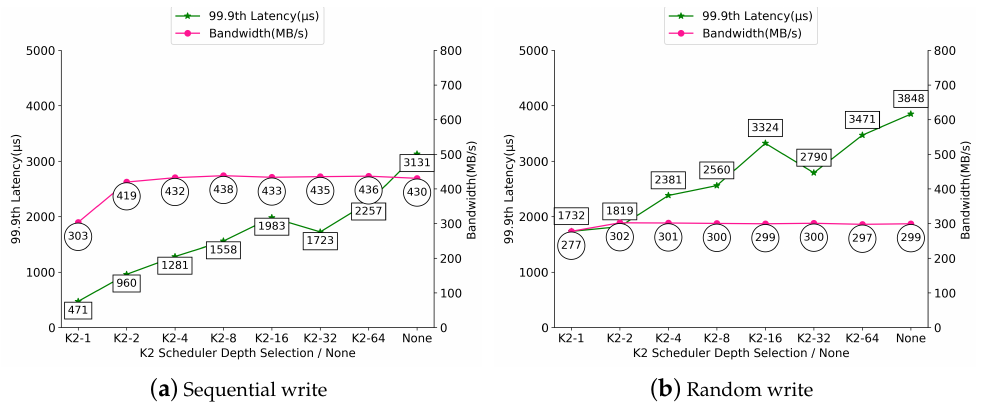
Figure 5. Performance of sequential/random write operations on a partially occupied